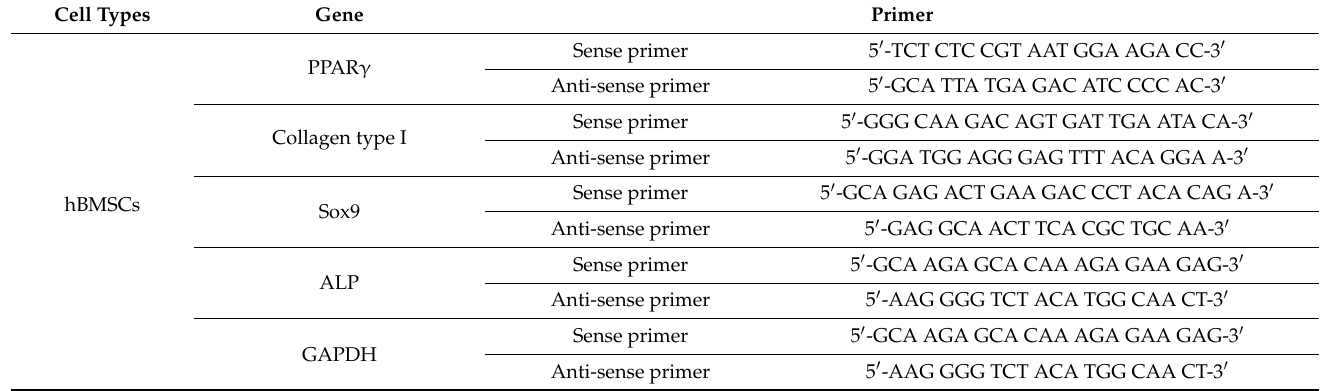
Table 3. The corresponding primers of stem and housekeeping genes used in RT-qPCR